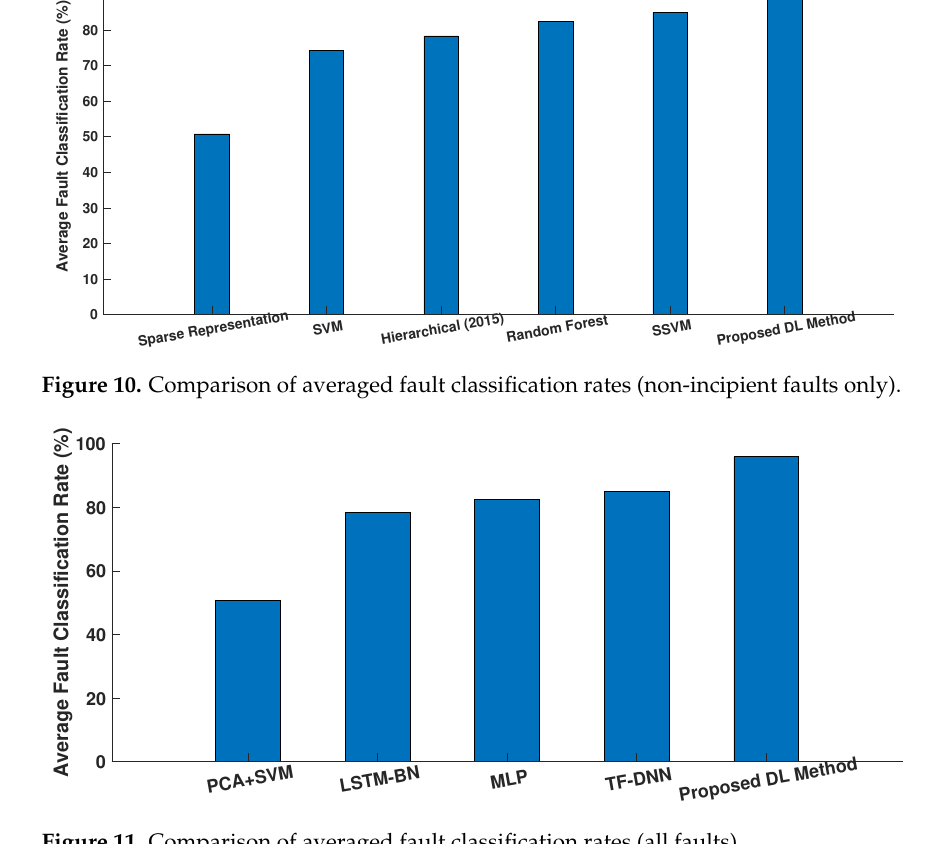
Figure 11. Comparison of averaged fault classification rates (all